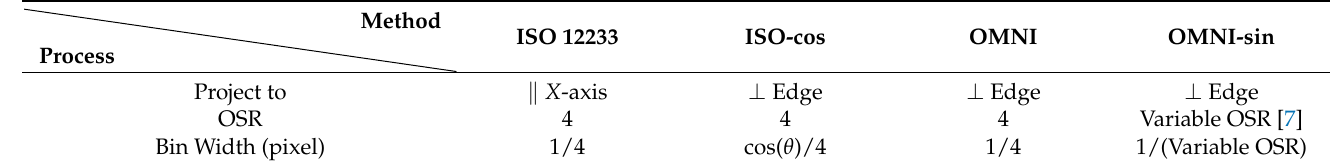
Table 1. Projection and binning process comparison among four edge